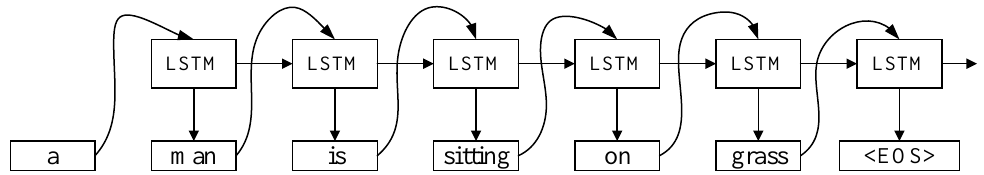
Figure 9. An example for generating sentence by LSTM language